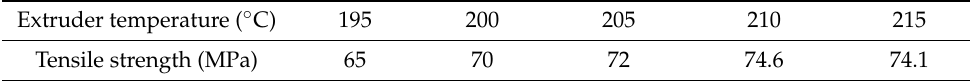
Table 4. Tensile strength vs. extruder temperature.